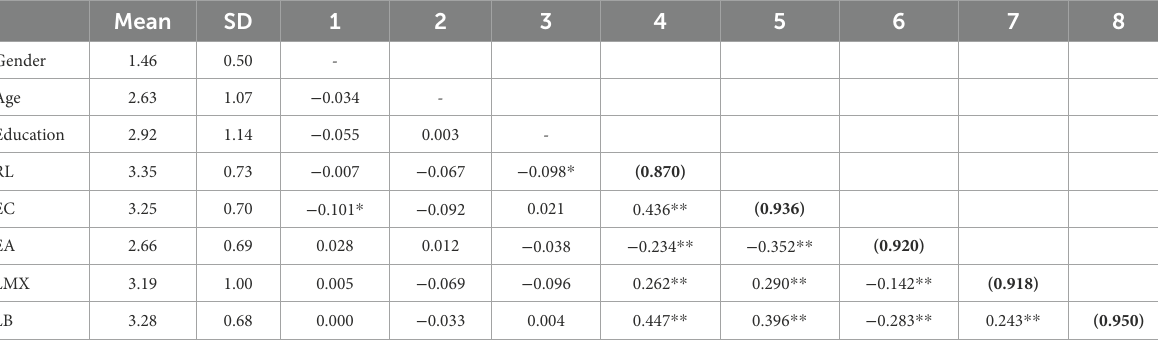
TABLE 3 Means, standard deviations, and correlations.